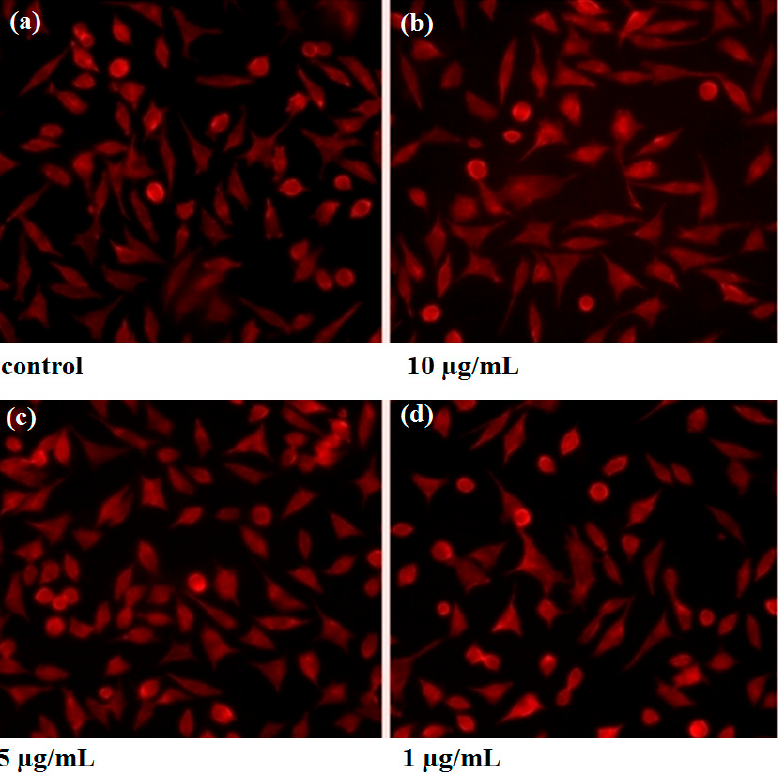
Figure 9. Images of fluorescence microscopy at 24 h of the L929 cultured cells grown in the presence of AgNPs: ( a ) control; ( b ) 10 μ g/mL; ( c ) 5 μ g/mL; ( d ) 1 μ g/mL.